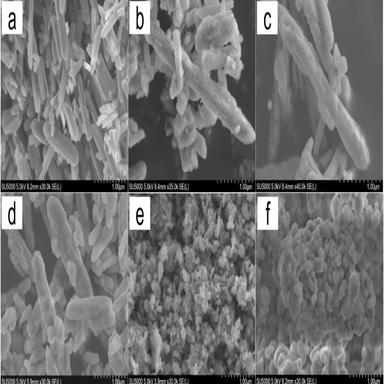
FESEM images of self-made β-MnO2 (a) and the synthesized r-LRMLOs at 550 ℃ for 5 h (b), at 850 ℃ for 12 h (c) and at 850 ℃ for 24 h (d) as well as reagent γ-MnO2 (e) and the comparisons of c-LRMLO (f).